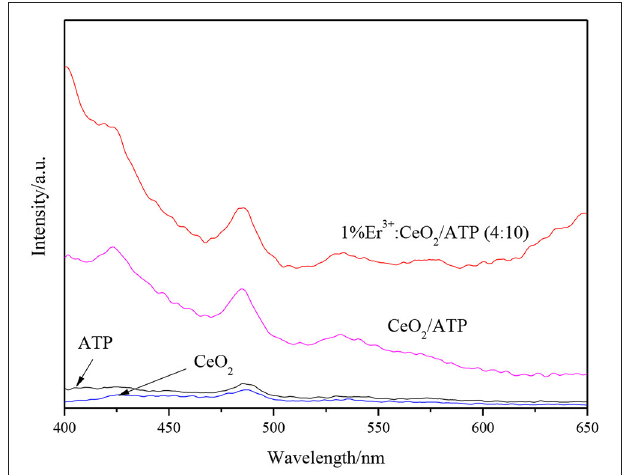
FIGURE 6 | PL patterns of ATP, CeO 2 , CeO 2 /ATP, and 1%Er 3 + :CeO 2 /ATP (4:10).